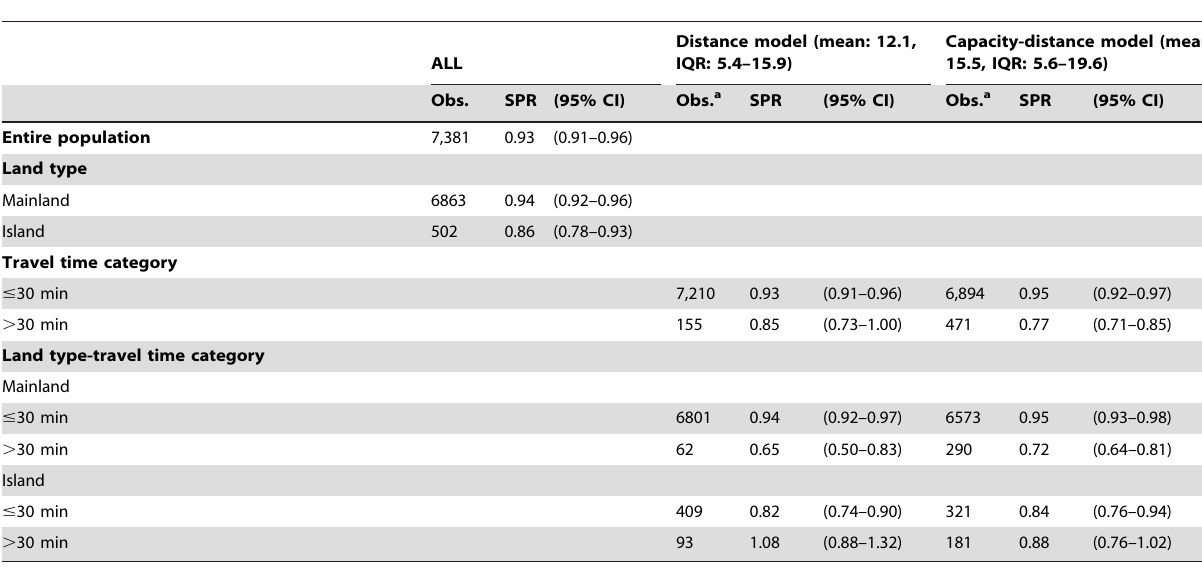
Table 3. Number, age- and sex-adjusted standard prevalence rate (SPR) and their 95% CIs of dialysis patients in each subgroup of population in 2011 in Hiroshima, Japan (total population n = 2,828,506 and census block n = 1,867 for the analysis).